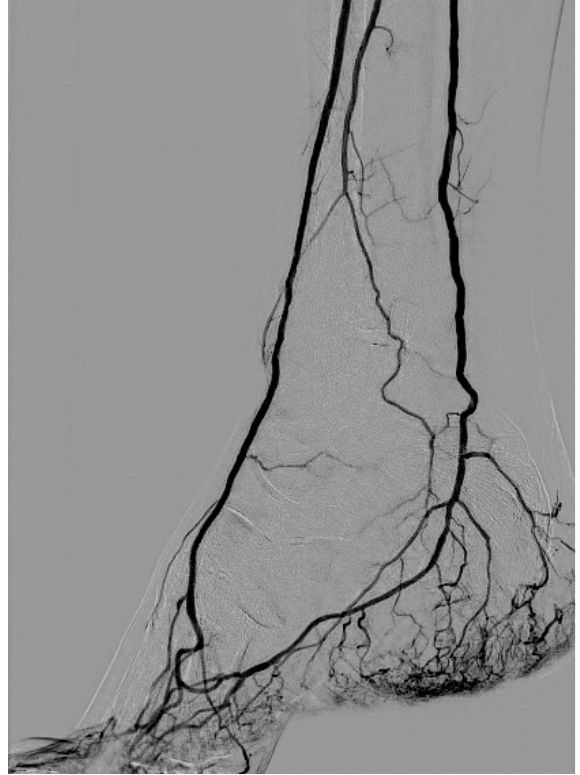
Figure 3. Lateral oblique DSA acquisition showing physiological vascularization of distal lower limb with good visualization of pedidial artery and plantar